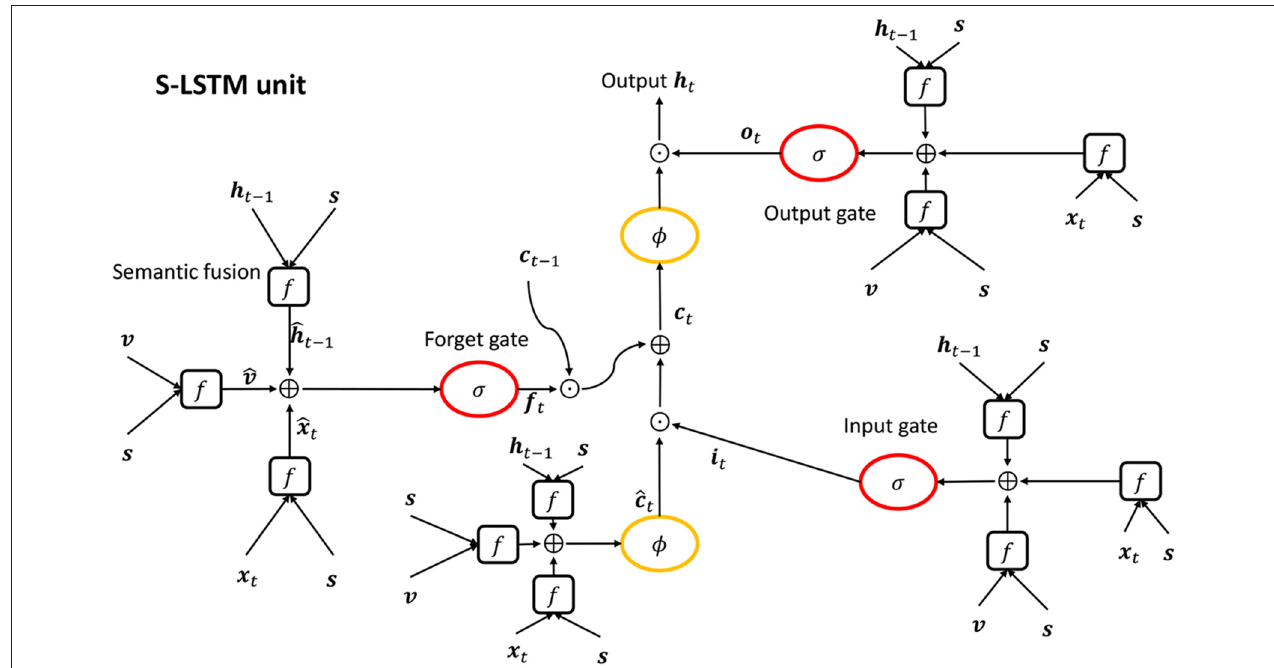
FIGURE 1 | The figure of SCN unit. σ , φ , semantic fusion ( f ) denotes a sigmoid function, a tanh function and Equation (5), respectively. ⊙ and ⊕ in a circle denote element-wise product and element-wise addition, respectively.